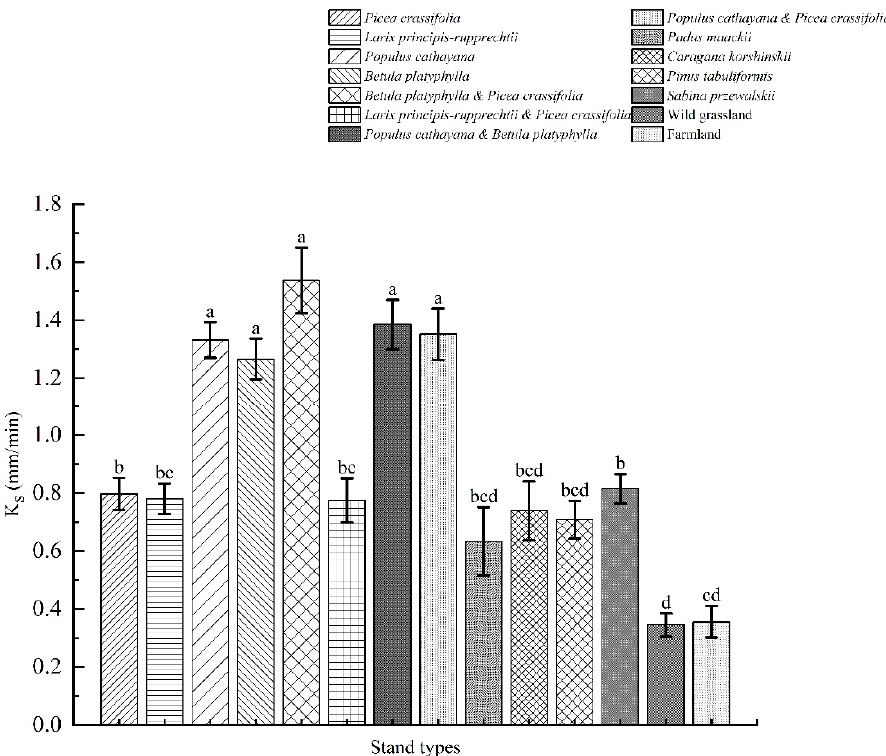
Figure 3. Analysis of K S significance difference among different vegetation types.